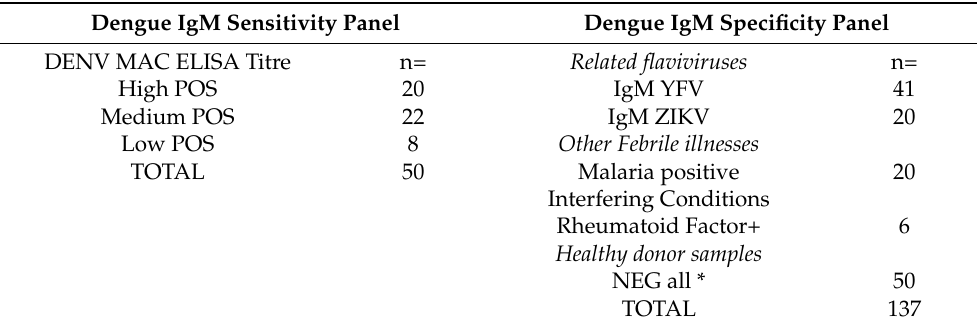
Table 2. Dengue IgM sensitivity and specificity